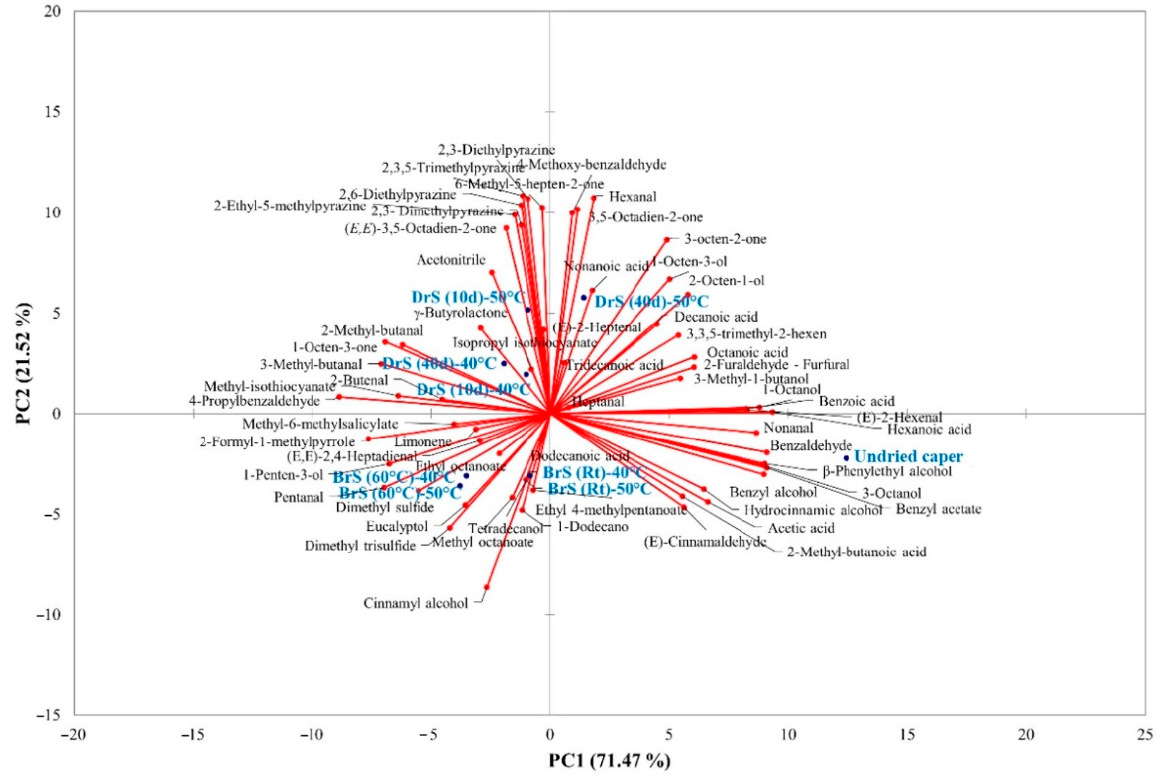
Figure 2. PCA loading plot showing the multivariate variation between samples in terms of volatile and aroma compounds.